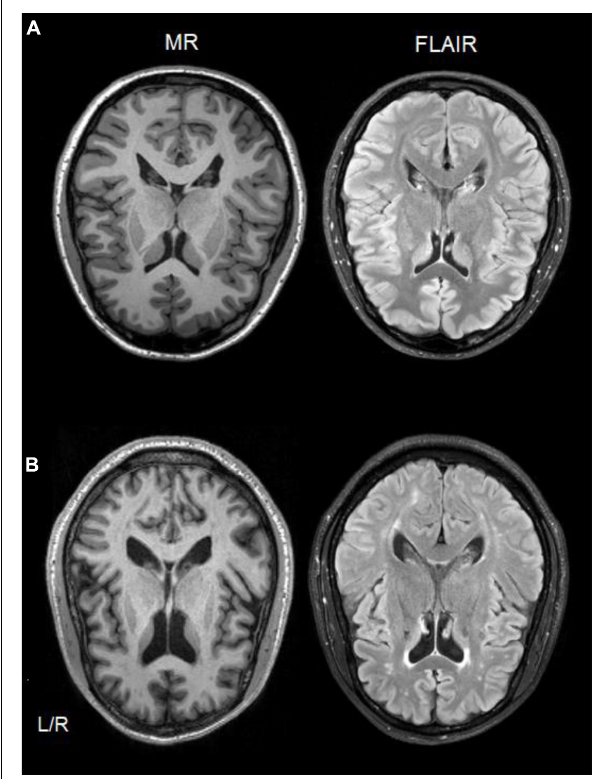
FIGURE 2 | Single-subject comparison of T1-weighted MR (left side) and FLAIR (right side) scans from a healthy control participant (A) , and a CUD patient (B) showing white matter hyperintensities in both scan